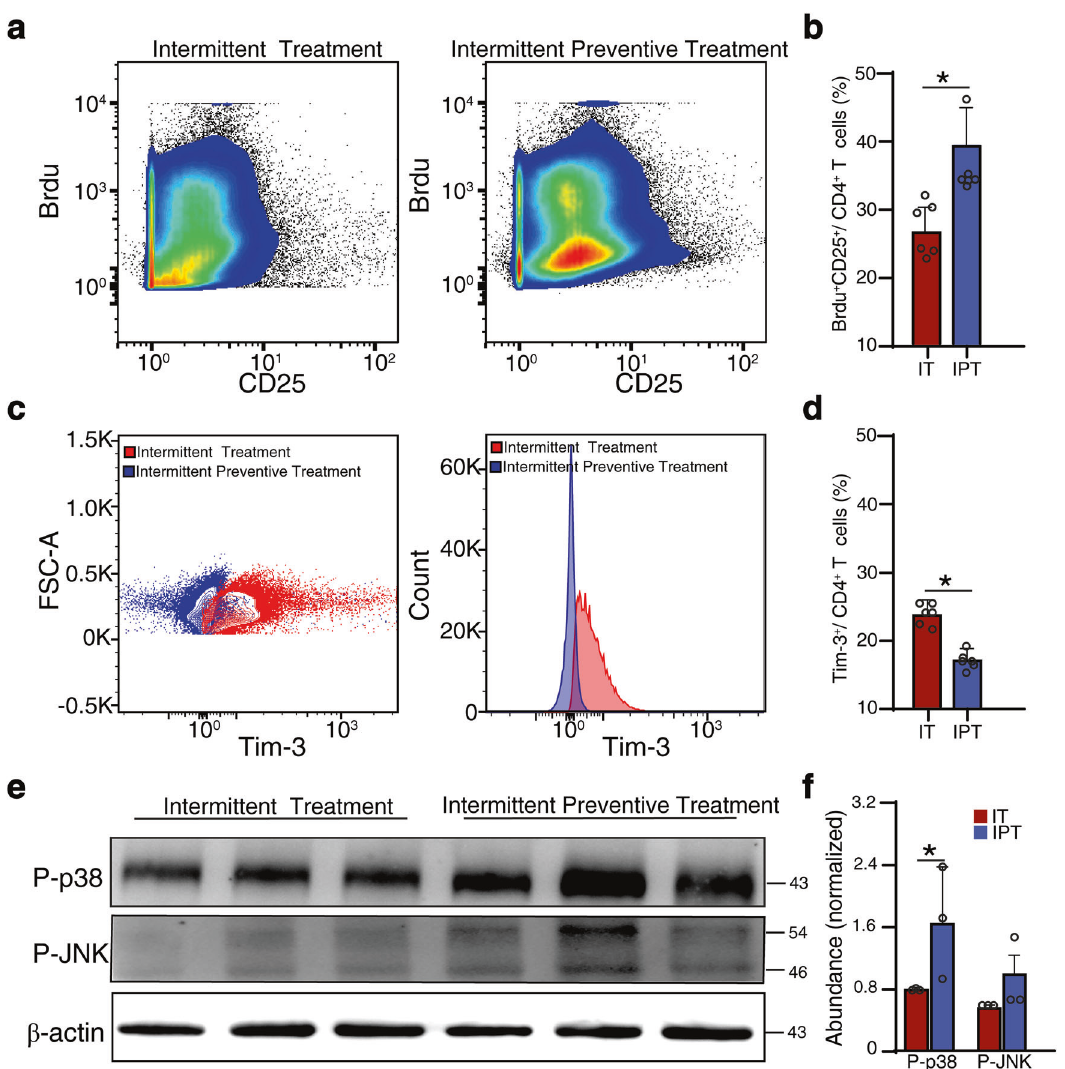
c Histograms show representative fl ow cytometric stainings (left) and mean fl uorescence intensities (right) of Tim-3, and d Bar graph shows differences in percentage of Tim-3 + (CD4-gated) T cells in the IT and IPT group. e Representative images of triplicate Western blot (WB) of phosphorylated- P38 and JNK, which were prominent in the IPT group than that in the IT group. Molecular weight (kDa) was labeled at the right. f Bar graph shows differences in normalized abundance of the two proteins between IT and IPT group. IT = Intermittent